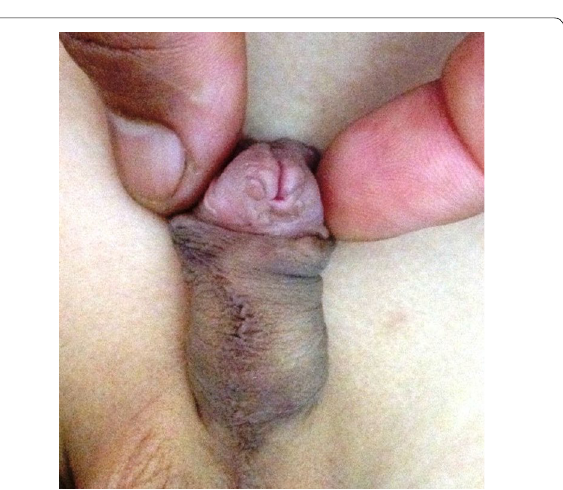
Fig. 7 At 6-month